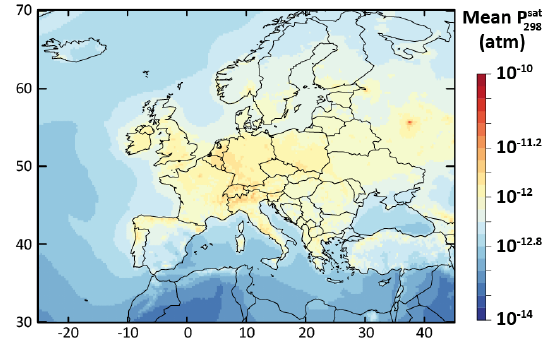
Figure 10. Simulated average volatility of OA in term of P sat upon Europe during the July–August 2013 period for the ref-VBS- GECKO model